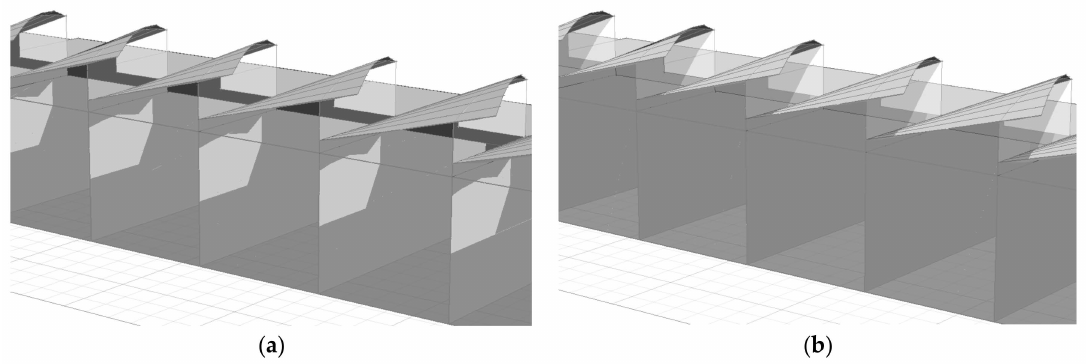
Figure 5. A comparison of the interior shadow range at 12:00 h. ( a ) Winter solstice; ( b ) summer solstice. The possibility of natural ventilation was also studied. The monitors have automated ventilation apertures that can be opened at certain levels of temperature and wind speed. The UVB amount of rays is therefore increased. Such vents are located on facades with different orientations to facilitate cross ventilation and remove excessive thermal gains (Figure 6).